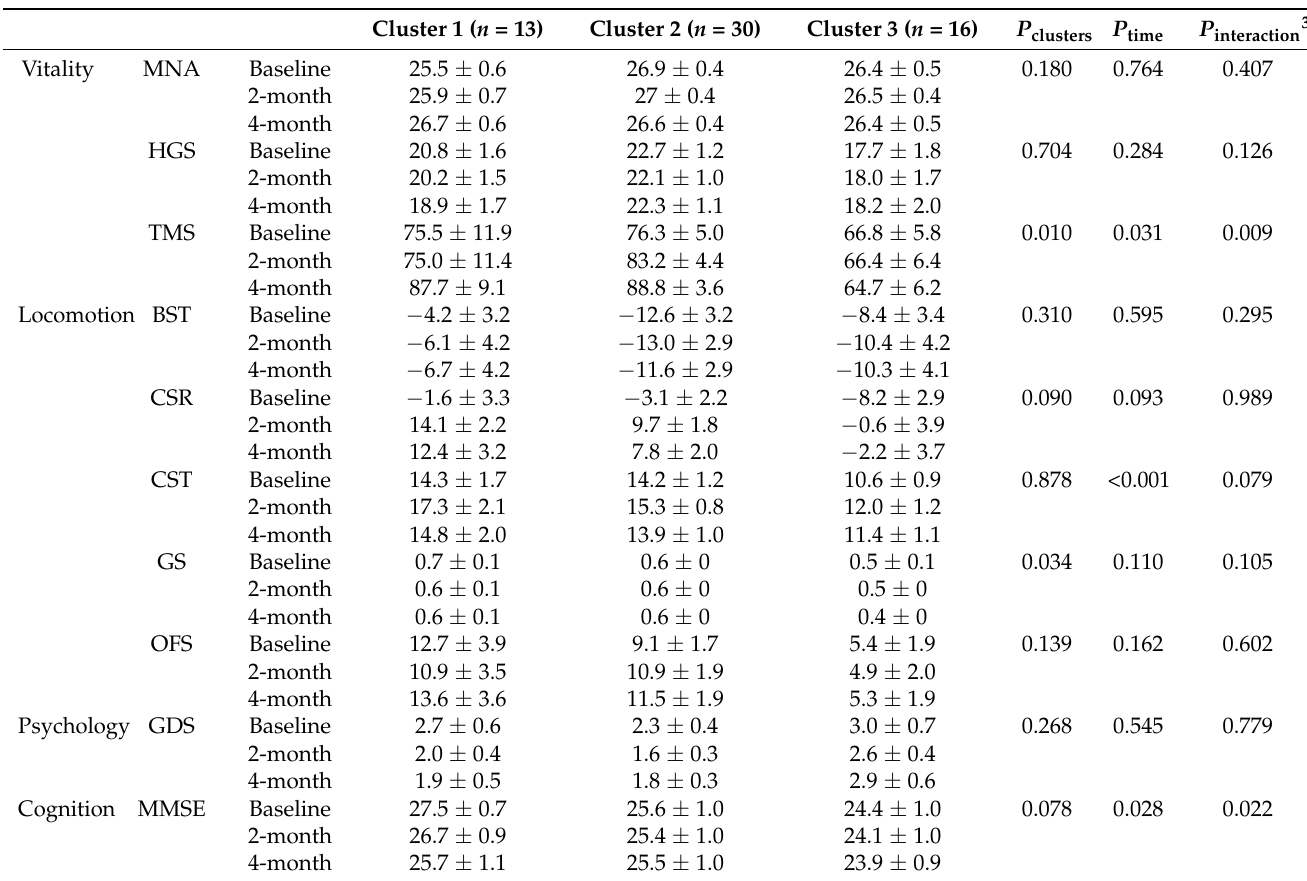
Table 3. Intervention effects on intrinsic capacity during the 4-month study period 1,2 .